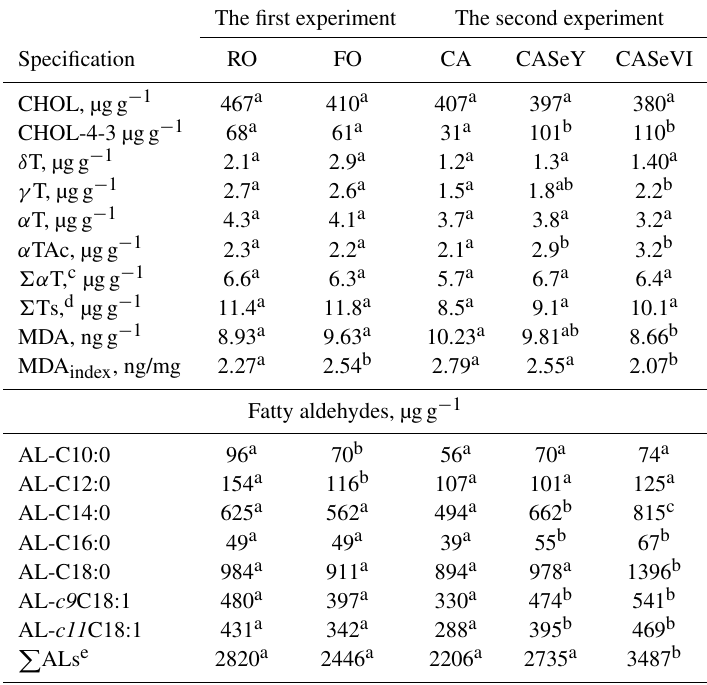
Table 5. The concentrations of cholesterol, CHOL-4-3, tocopherols (T), MDA, fatty aldehydes and values of PUFA peroxidation index a in the brains of lambs b . The first